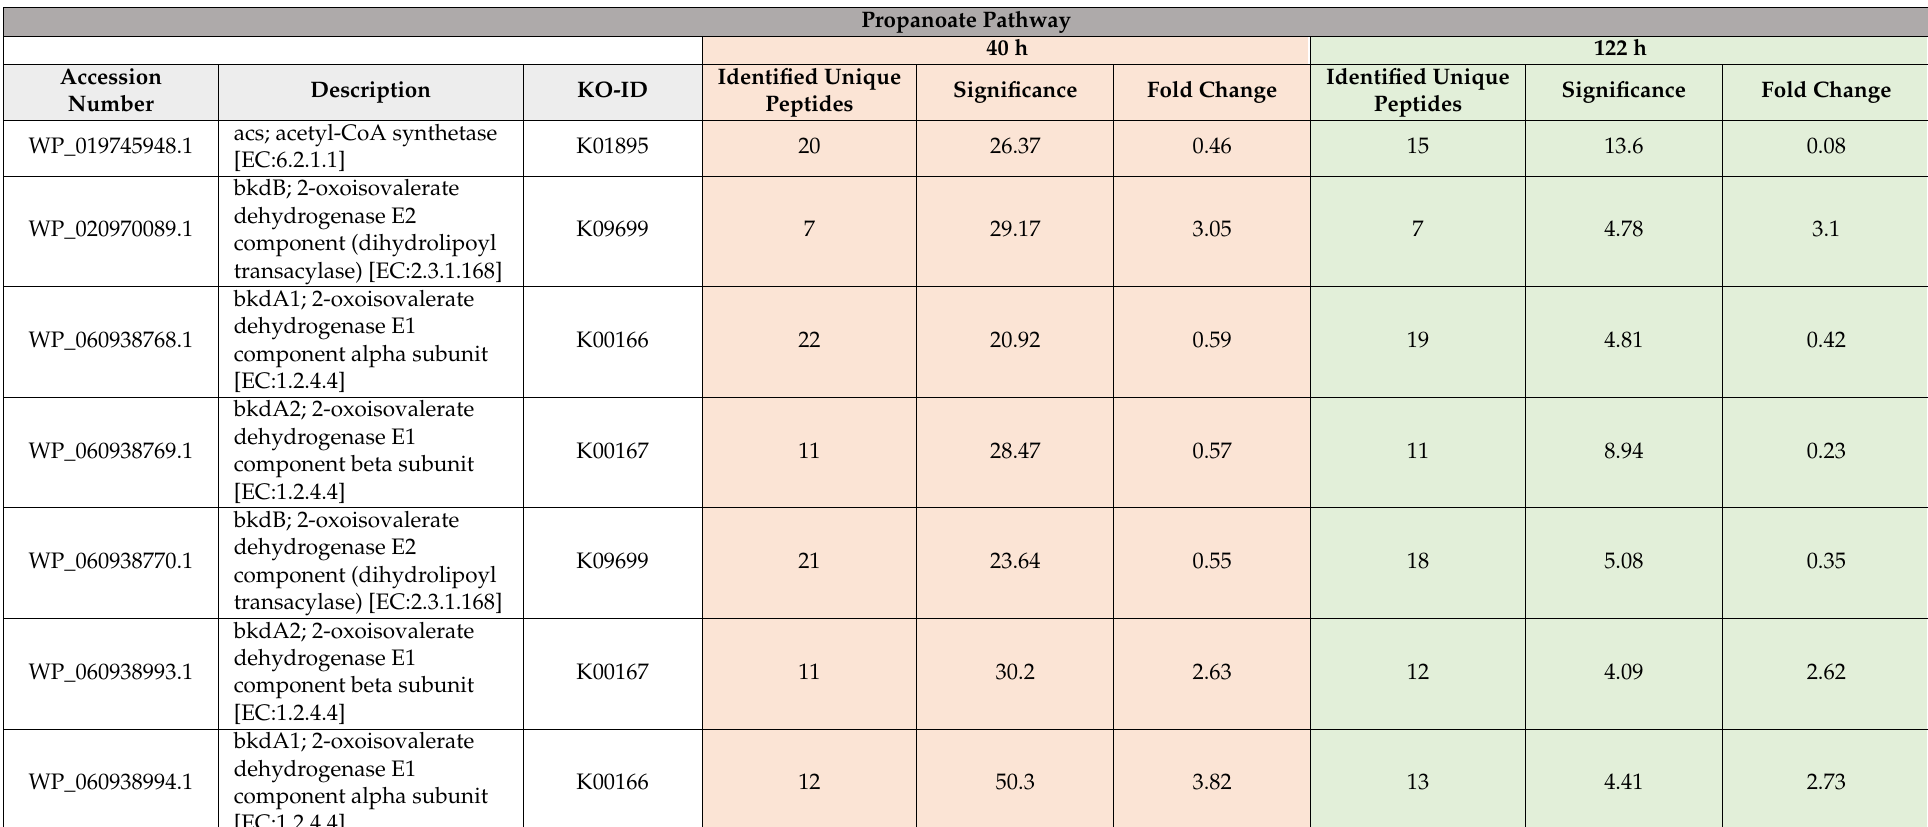
Table 2. Selected proteins involved in propanoate metabolism and cyclopropane-fatty-acyl-phospholipid synthesis discussed here. Protein abundance and fold change in samples grown under white light were compared to non-illuminated control. NCBI Accession numbers as well as matched KO identifiers are listed. Further identified unique peptides, significance and fold change at 40 h and 122 h of samples are stated. Fractions below 1 depict downregulation. n.d. = not